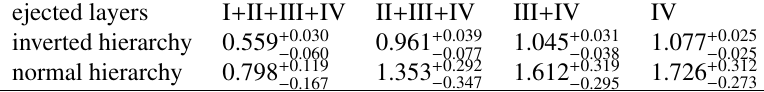
Table 1. Calculated abundance ratios ( 7 Li + 7 Be) / ( 11 B + 11 C) in our nucleosynthesis model. Associated errors represent uncertainties of the final yields as shown in Fig. 1 which arise from the uncertainty (2- σ C.L.) of the nuclear reaction rate for 11 C( α, p ) 14 N. See text for the four